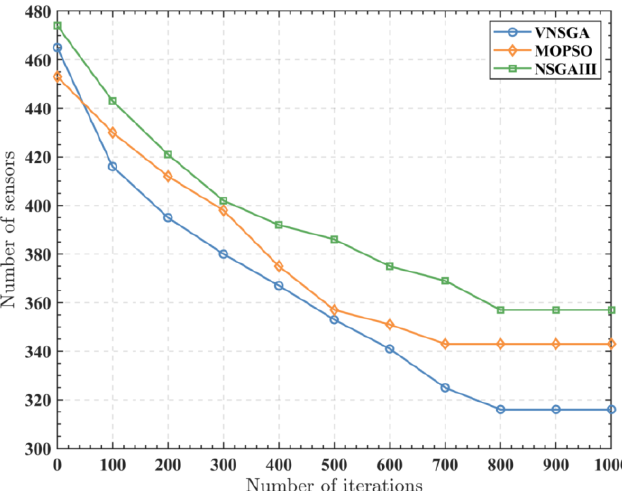
Figure 26. Number of sensors for three algorithms with different iterations with respect to area B.